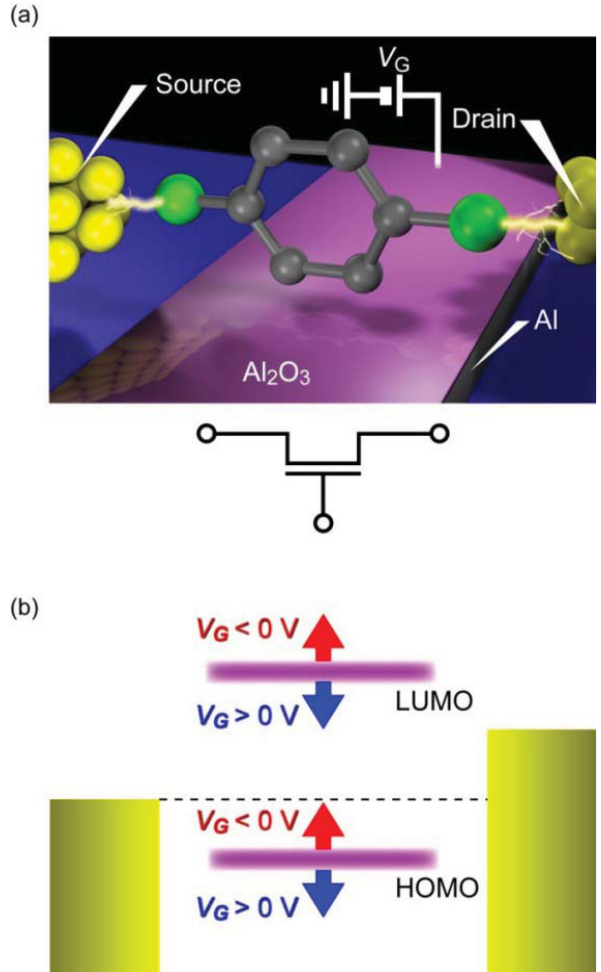
Figure 10. Au/1,4-benzenedithiol/Au single-molecule FETs. ( a ) A schematic view of the single-molecule FET. The Al/Al O bottom gate electrode was used for modulating 2 3 the source-drain current flowing through an individual benzenedithiol molecule; ( b ) The HOMO and the LUMO are fixed at the positions relative to the Fermi level (dotted line) with the source-gate voltage V . The orbital energy levels can be shifted upward (downward) by G the negative (positive) V G